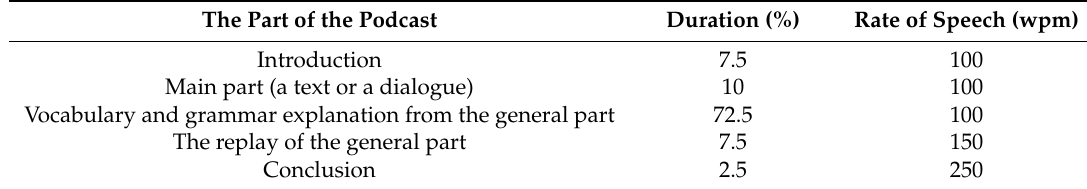
Table 4. The structure of the